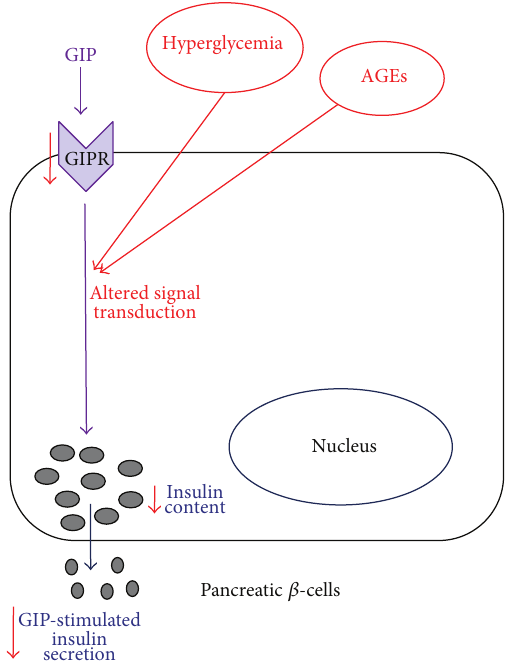
Figure 6: Schematic representation of the effects of hyperglycaemia and AGEs on GIP responsiveness in the pancreatic beta cell line HIT-T15. Chronic hyperglycemia leads to formation and accumu- lation of AGEs; therefore the diabetic milieu may be represented as a hyper glycemic environment (HG) reached in AGEs (GS). Together, HG and GS contribute to damage pancreatic beta cell function: expression of GIPR is reduced, and its intracellular signaling is altered, leading to a reduced secretory response to GIP and potentially explaining the loss of GIP responsiveness in T2